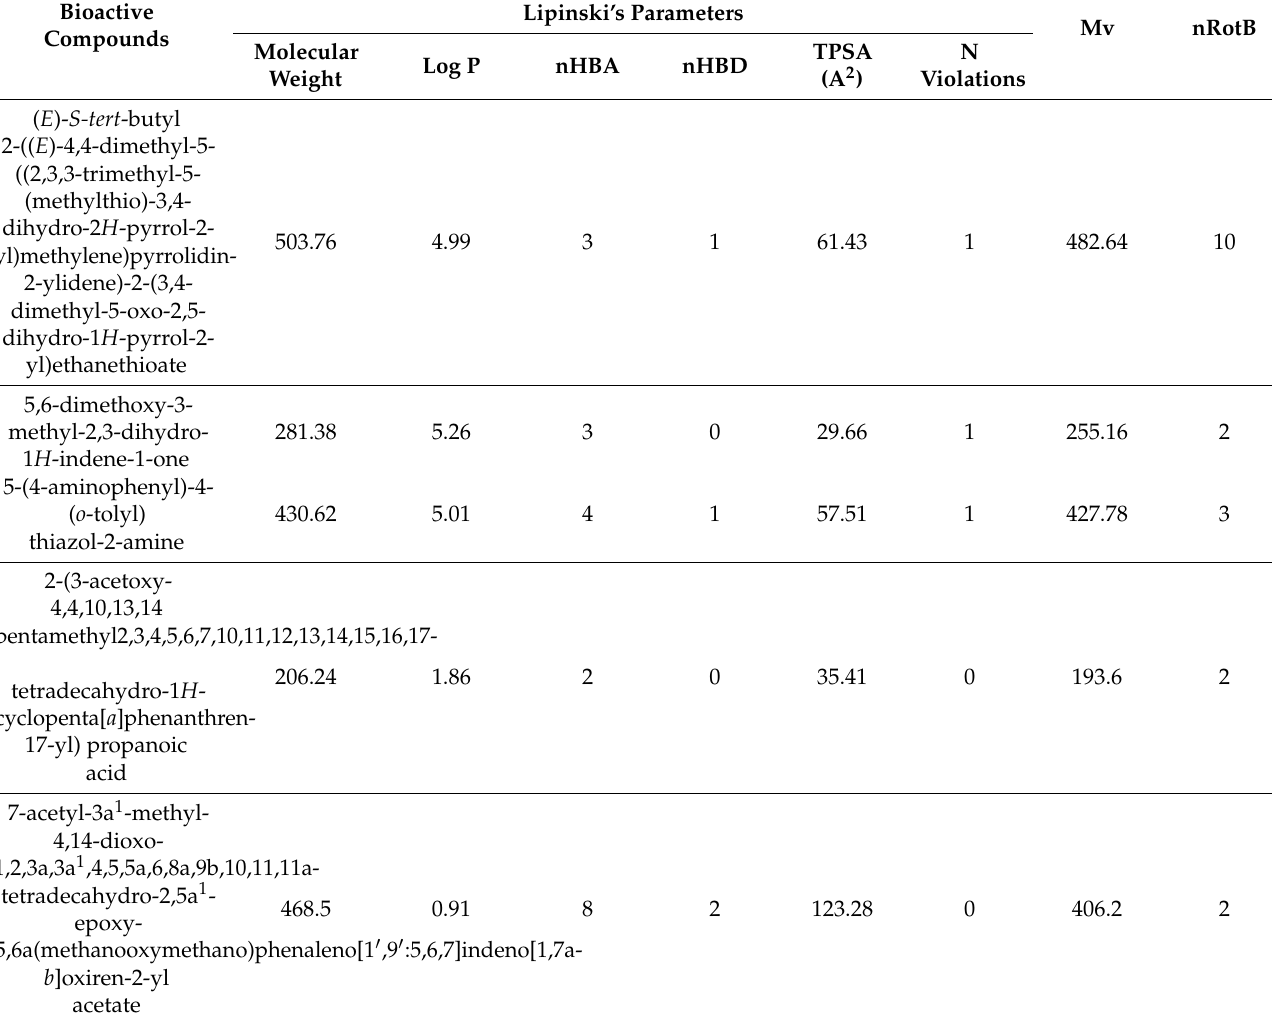
Table 4. Drug likeness (indicated by Lipinski properties) of the selected bioactive compound of Azima tetracantha analyzed with Swiss